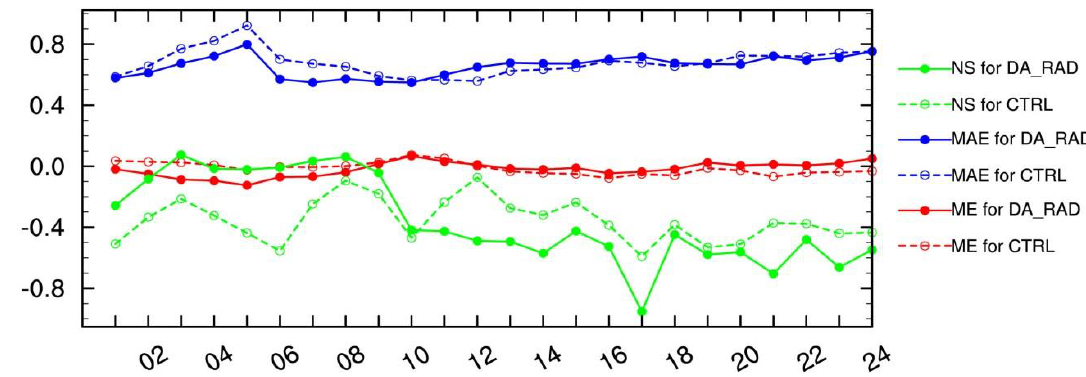
Figure 10. Statistic metrics of mean error (ME), mean absolute error (MAE), and Nash–Sutcliffe (NS) efficiency coefficient for forecasts against observed hourly rainfall over Domain 2 with a resolution of 3 km.